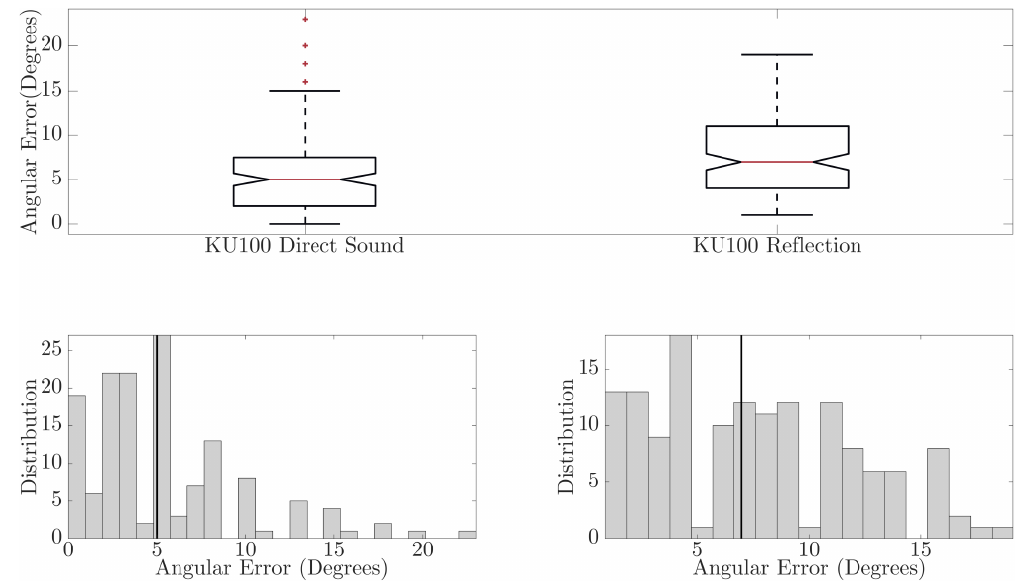
Figure 7. Comparison of angular errors in the neural network direction of arrival predictions for measurements with the KU100. The top image is a boxplot comparison of the angular error in the neural network predictions for the direct sound and reflected components; the bottom left is a histogram showing the error distribution for the direction of arrival predictions of the direct sound; and the bottom right is the error distribution for the direction of arrival predictions of the reflected components. The black line on the histograms depicts the median angular error.